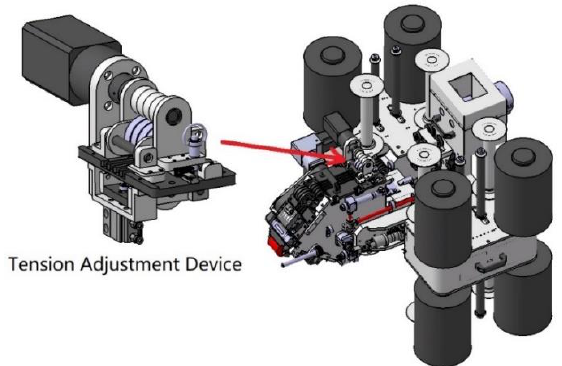
Figure 20. AFP head with real-time tension adjustment device.